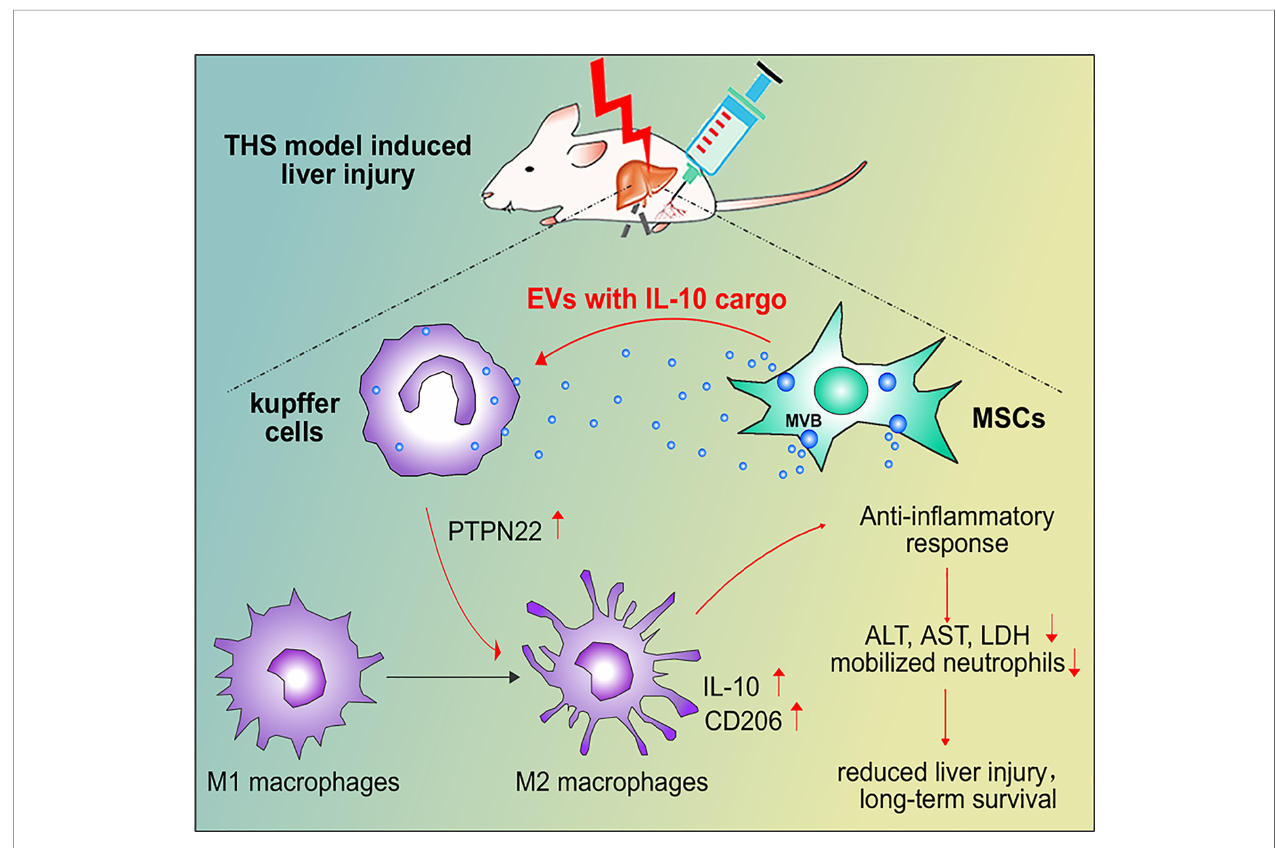
FIGURE 7 | Schematic model of the interactions among MSC-EVs, IL-10, PTPN22 and Kupffer cell polarization after THS. After THS, MSC-EVs primarily accumulate in liver tissues, where they are taken up by Kupffer cells. MSC-EVs carrying IL-10 induce the expression of PTPN22, IL-10 and CD206 and promote the anti- in fl ammatory polarization of Kupffer cells, which further reduces the plasma levels of LDH, ALT and AST, decreases liver neutrophil in fi ltration, and restricts neutrophil mobilization from bone marrow during THS. These effects consequently reduce THS-induced hepatic injury and prolong animal